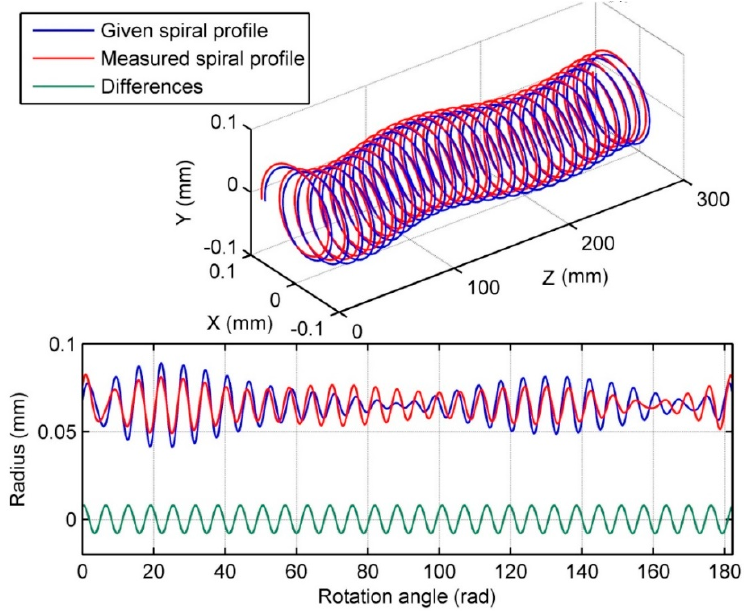
Figure 11. Comparison of the measured spiral line profile with given one in the case of ideal measurement. Here, angular position of probes ϕ n ( n = 1,2, · · · ,5 ) is 0 ◦ , 395 ◦ , 838 ◦ , 1236 ◦ , 1659 ◦ , respectively, and pitch of spiral line is T = 10 mm. Number of total rotating circles of spiral line is M = 29 .